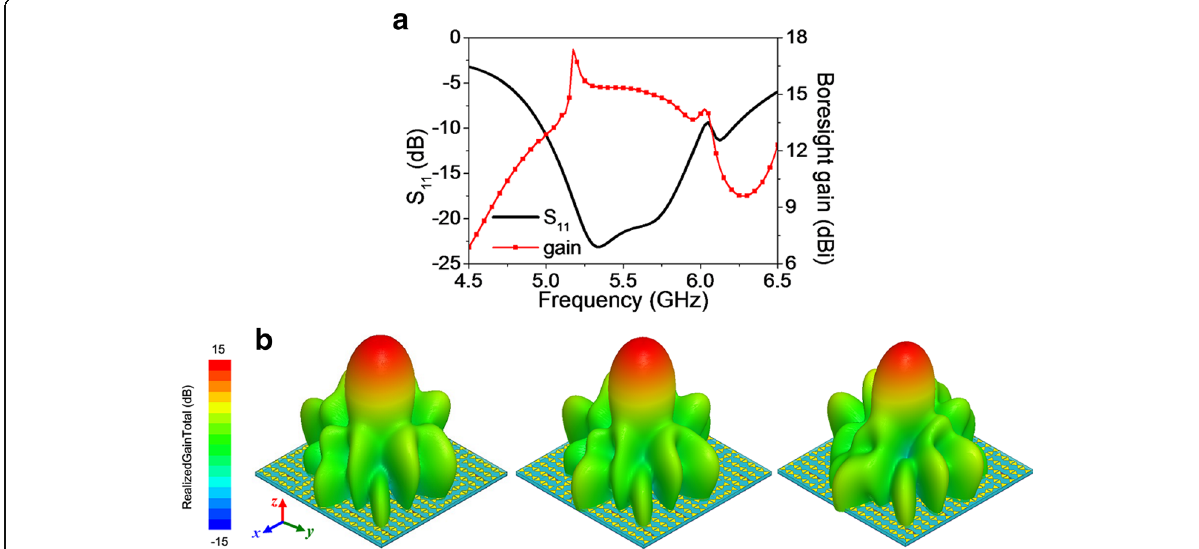
Fig. 6 Linear radiation properties of the EMMS with “ 0 ” and “ 1 ” fed with equal magnitude and phase. a Reflection coefficient S 11 and boresight gain versus frequency. b 3D LP radiation patterns at 5.35, 5.5, and 5.75 GHz (from left to